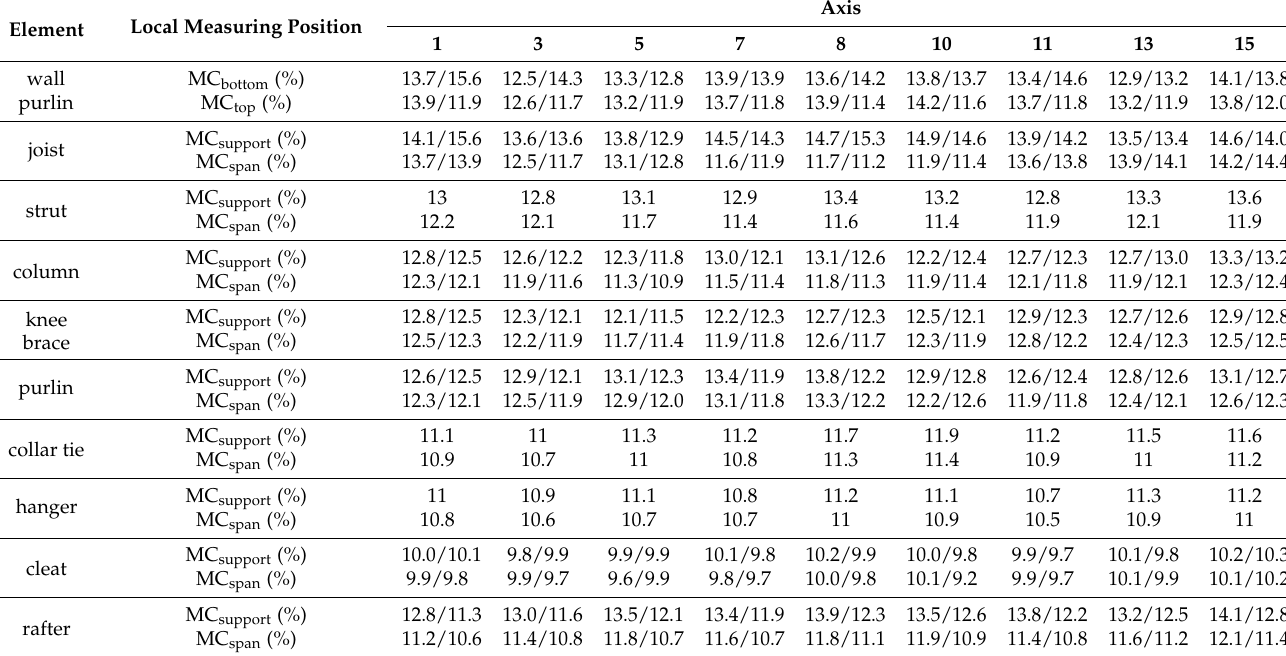
Table 1. Moisture content measurements